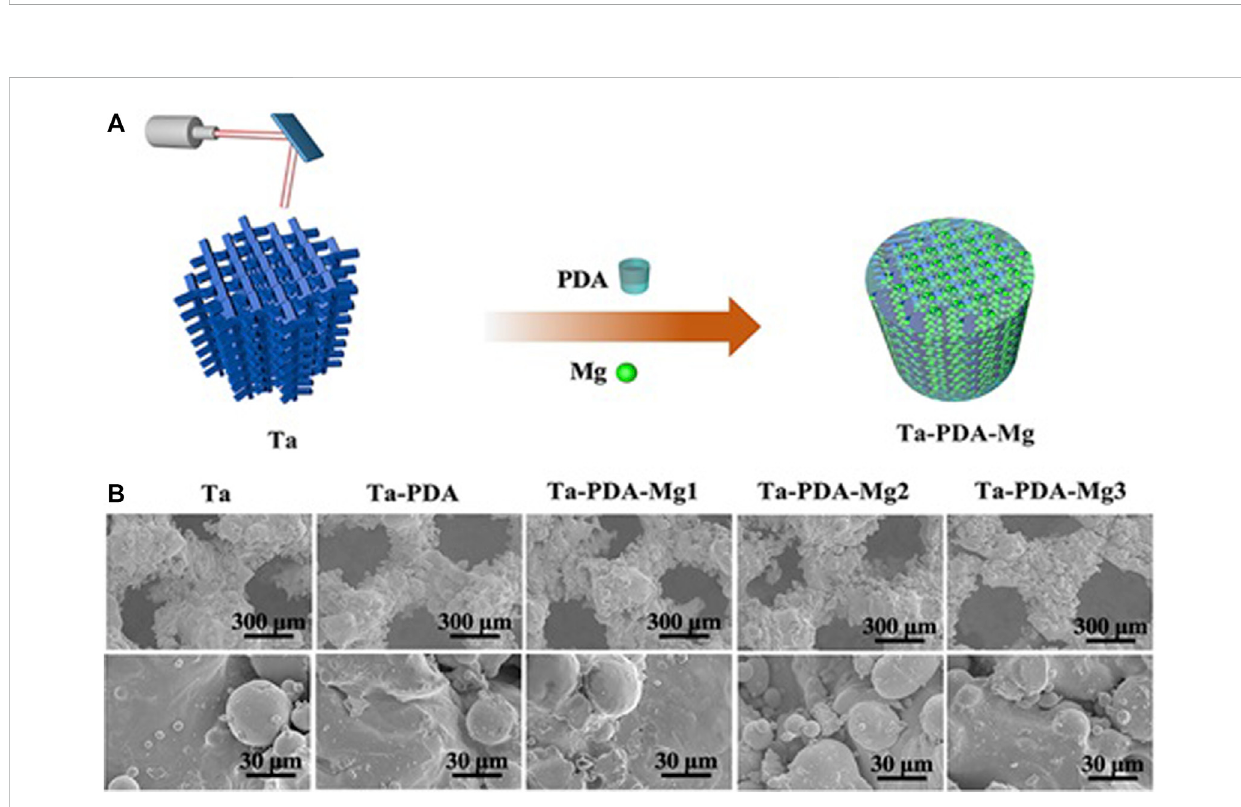
Schematics of Ta-PDA-Mg scaffold fabrication process (A) , and SEM images of the scaffold (B) (Ma et al., 2020b) Copyright ©2020 Published by Elsevier